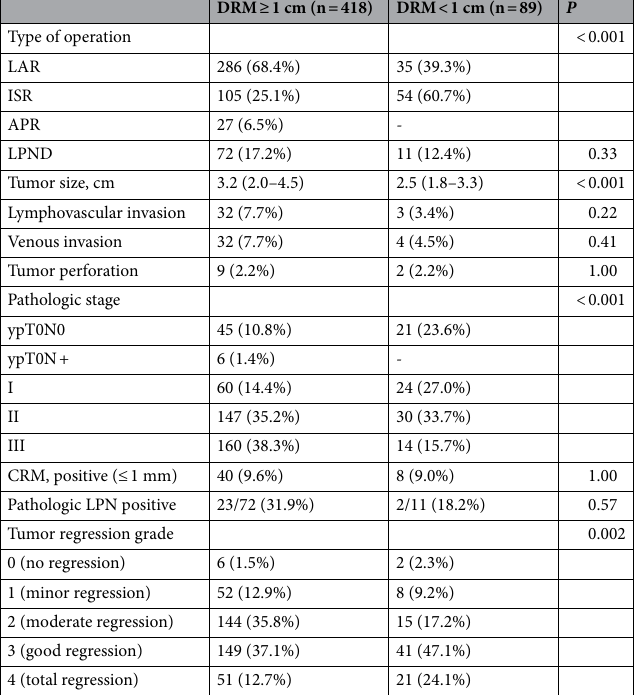
Table 2. Operative and pathologic findings. DRM, distal resection margin. LAR low anterior resection, ISR intersphincteric resection, APR abdominoperineal resection, LPND lateral pelvic lymph node dissection, CRM circumferential resection margin, LPN lateral pelvic lymph